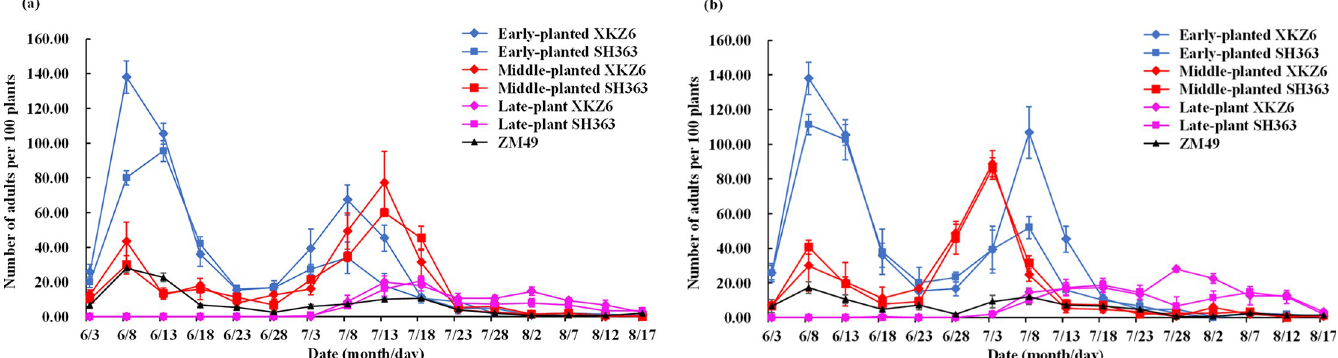
Fig 2. Population dynamics of Lygus pratensis adults on field plots-established with cotton and sunflower with different planting dates in 2015 (a) and 2016 (b). ZM49 is cotton, XKZ6 and SH363 are sunflower varieties. The same as below.